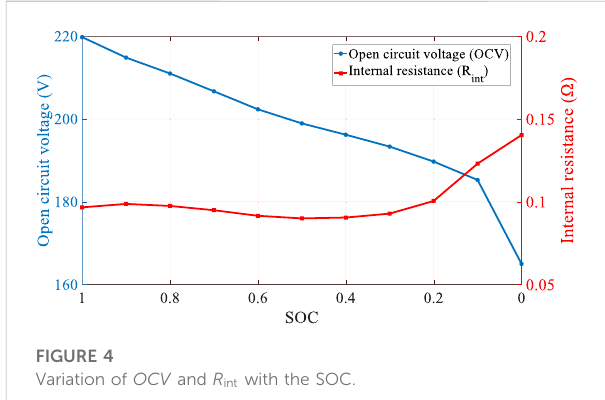
FIGURE 4 Variation of OCV and R int with the